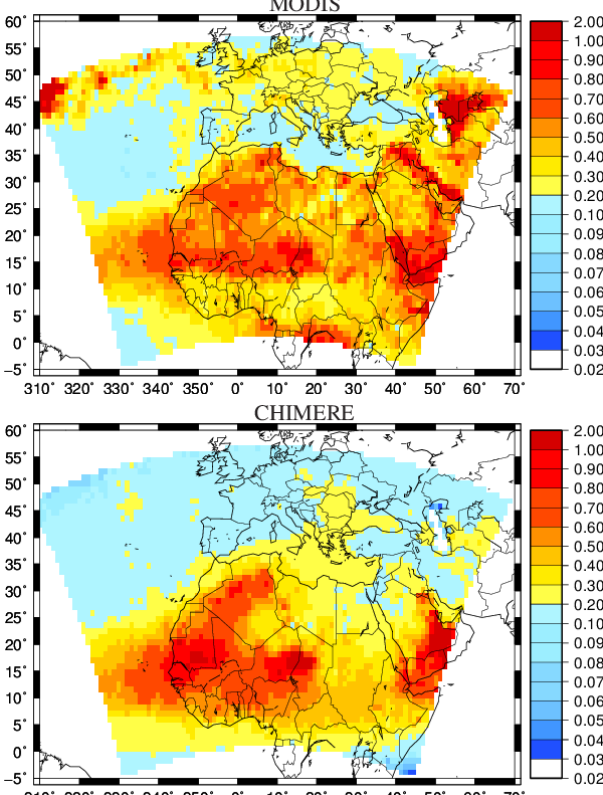
Figure 13. Comparison of AOD measured by MODIS (top) and modeled with CHIMERE (bottom). This AOD corresponds to the mean averaged value over the period from 6 June to 15 July